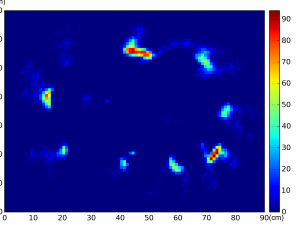
Figure 13. The total number of occupied